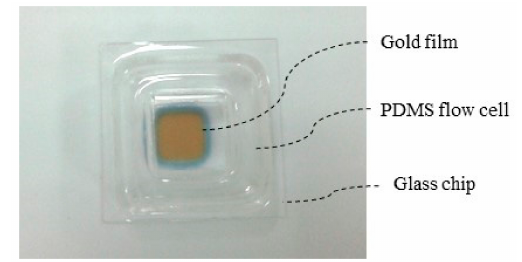
Figure 2. Photograph of integrated SPR chip and flow